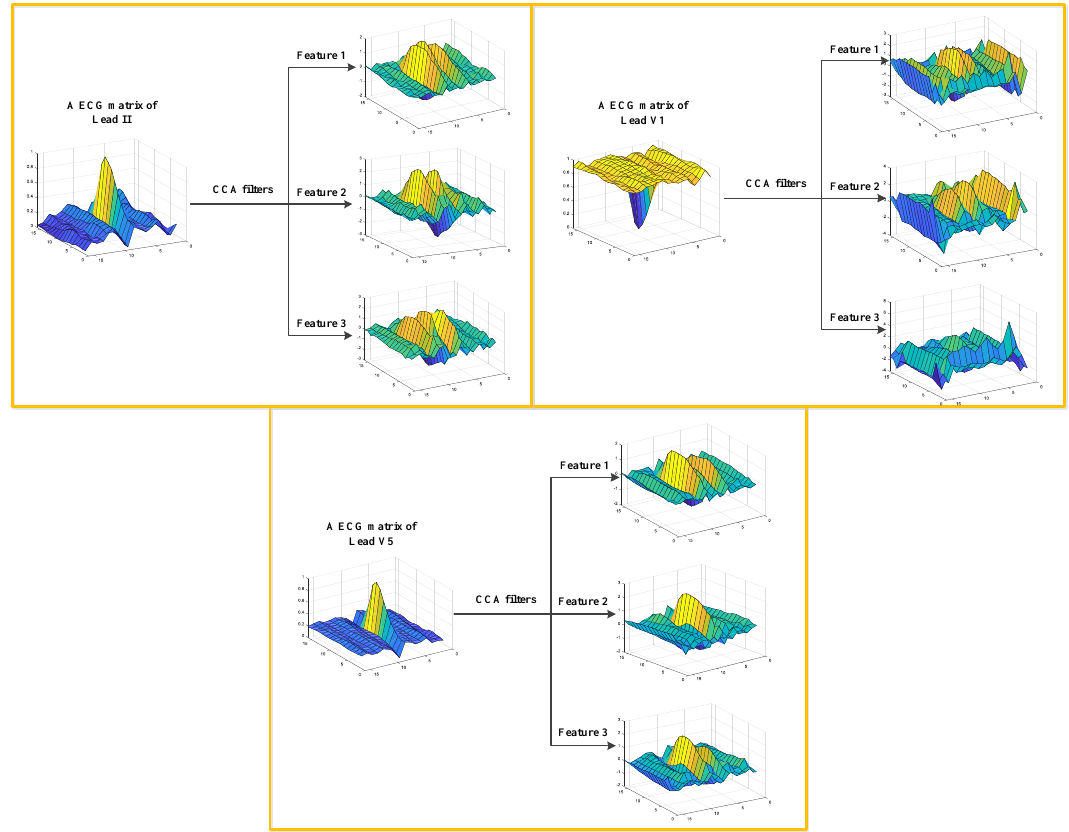
Figure 9. The PFBs obtained by the first convolutional layer of TL-CCANet.